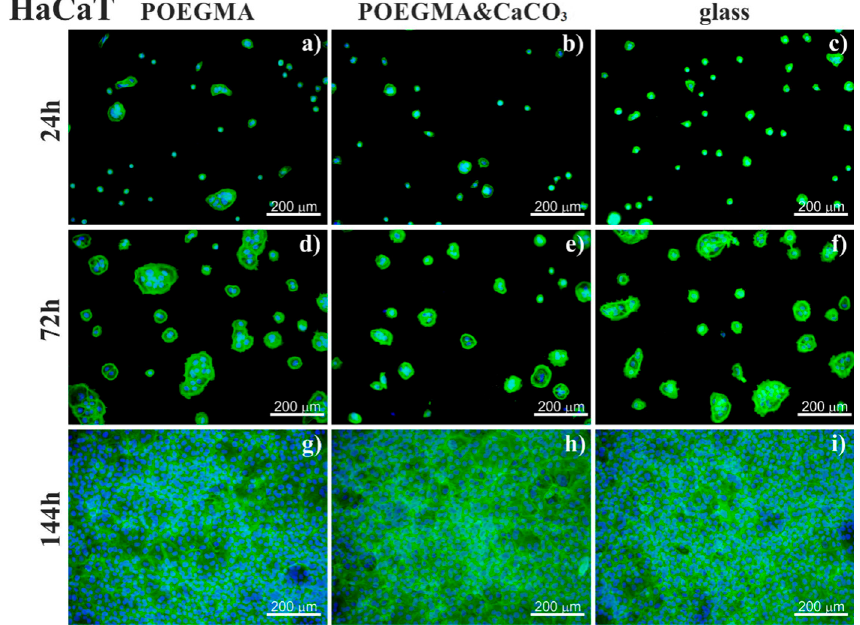
Figure 7. Fluorescence images of HaCaT cells after 24 ( a – c ), 72 ( d – f ) and 144 h ( g – i ) of cultivation on glass surface ( c,f , i ), POEGMA ( a , d , g ) and POEGMA-grafted brush coatings with incorporated CaCO 3 NPs ( b , e , h ).